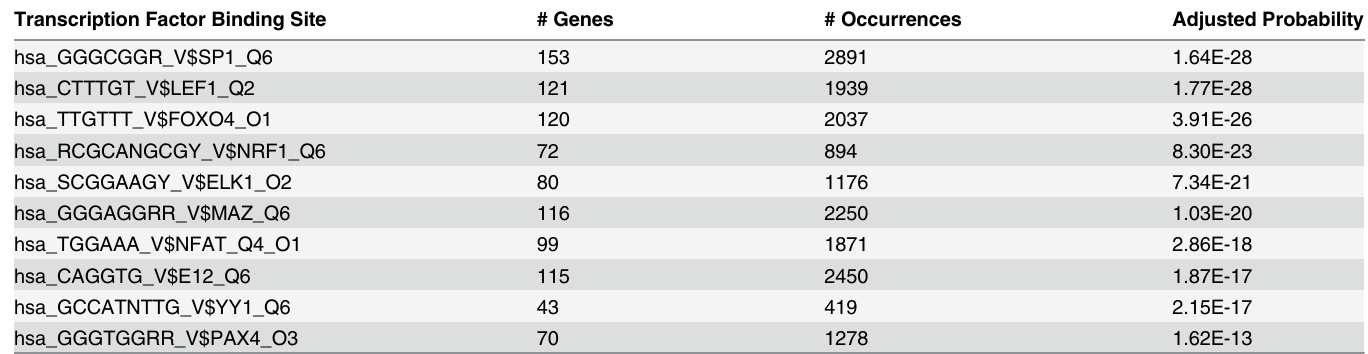
Table 5. Top 10 transcription factor binding sites significantly over-represented in the network of genes that were significantly downregulated in response to transient hypoxia in fetal pituitary.